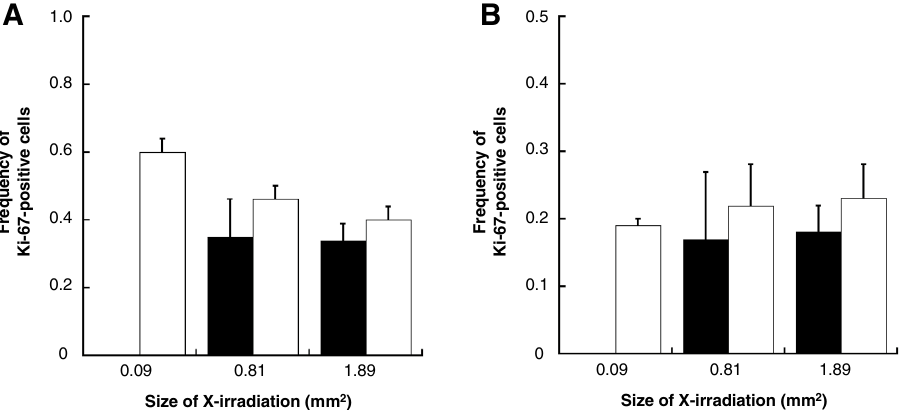
Figure 5. X-irradiated field area distribution of Ki-67-positive cells. X-irradiated field sizes of 0.81 mm 2 and 1.89 mm 2 were divided into 0.3 mm × 0.3 mm, and the X-irradiated field area distributions of Ki-67-positive cells were analyzed at 24 h ( A ) and 48 h ( B ) post-irradiation. After that, we investigated the frequency of Ki-67- positive cells located in area having not contact (black bar) or contact (white bar) with non-irradiated area of a cell population. However, since the areas with X-irradiated field seizes of 0.09 mm 2 are totally in contact with non-irradiated area, there is no data for the area in not contact with non-irradiated area. The data were pooled from three or four independent experiments and the results were represented as mean ± standard error. These figures were created with KaleidaGraph